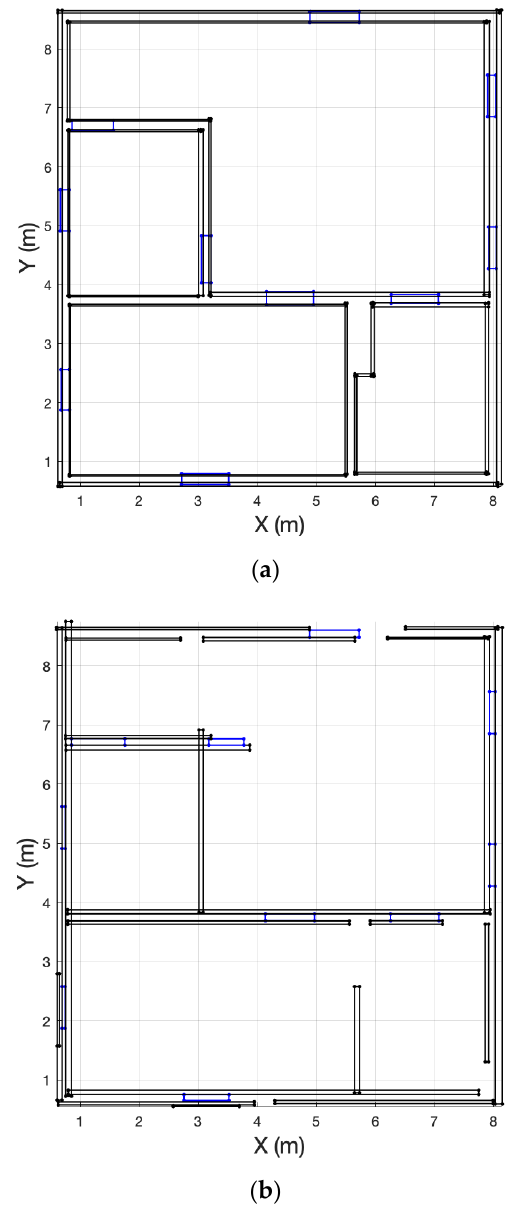
Figure 14. Jobber’s House Storey 1: ( a ) Truth model; ( b ) Calculated model. Walls in black, windows and doors in blue.